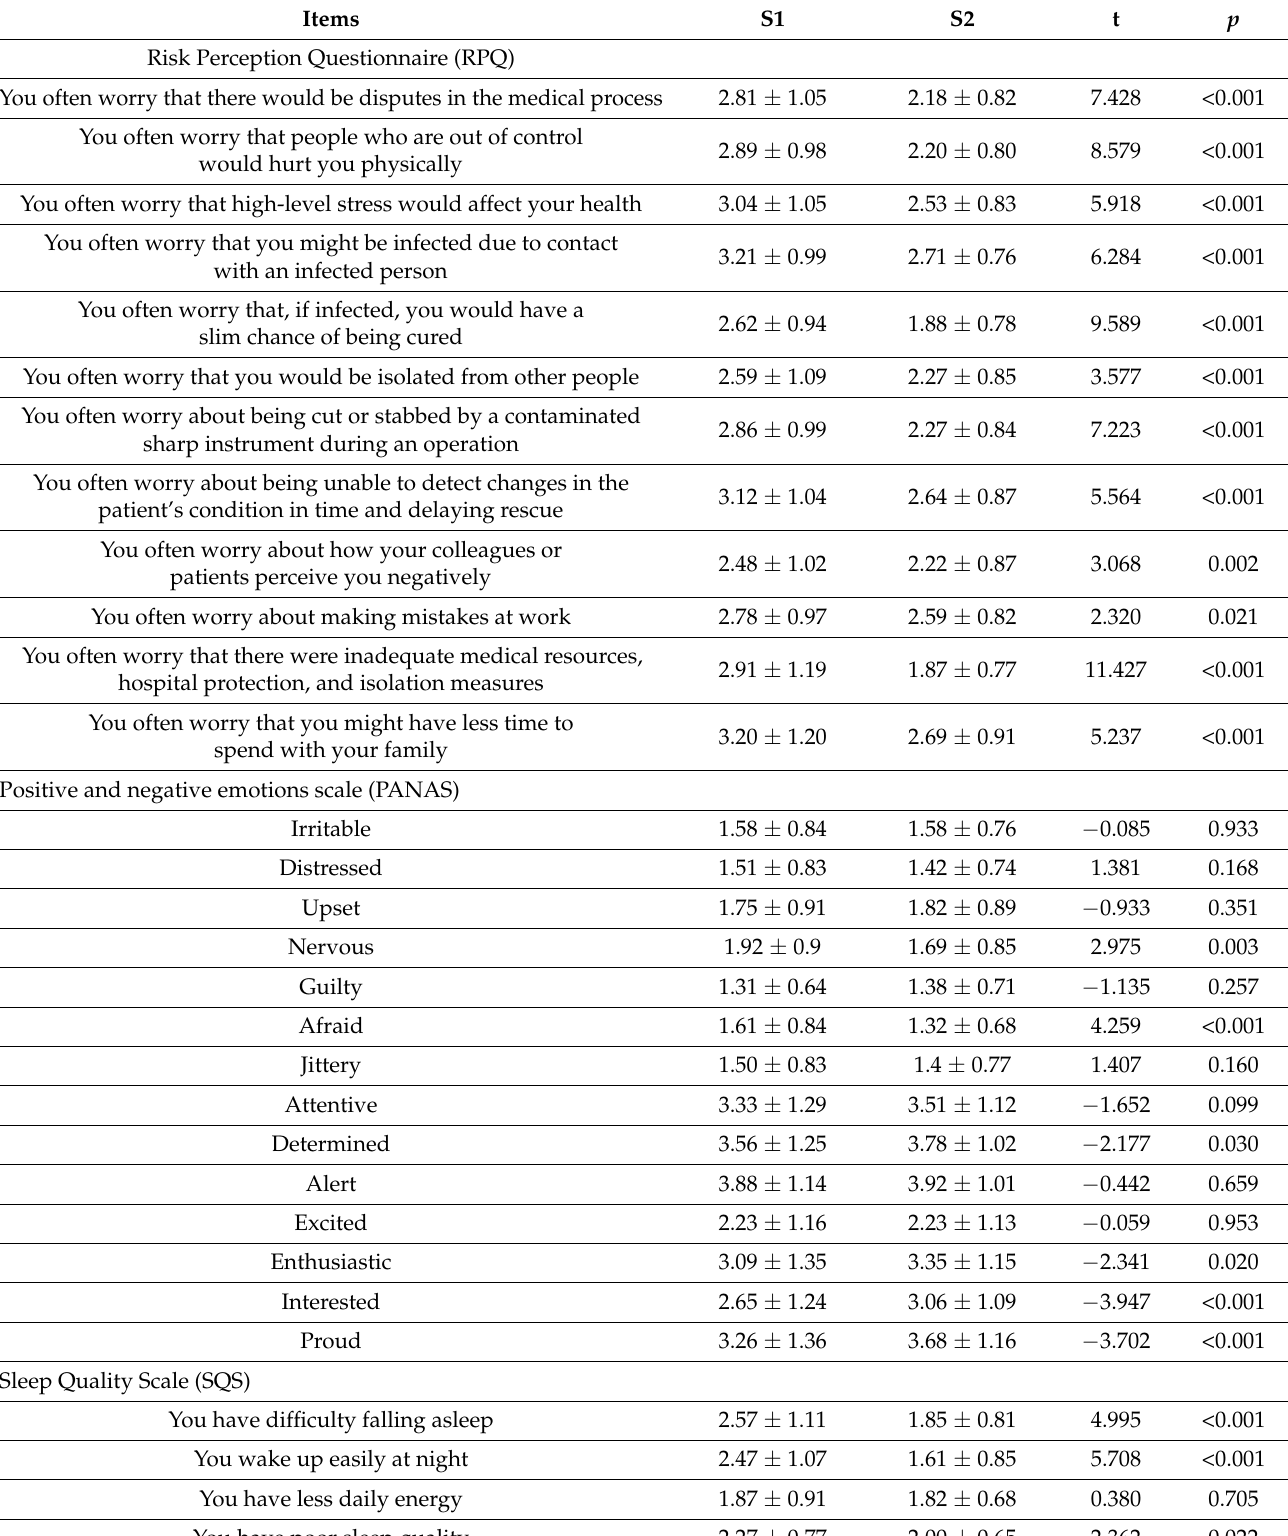
Table 2. Mean scores of each item from RSQ (a 5-point scale for none/often), PANAS (a 5-point for none/strong), and SQS (a 4-point scale for